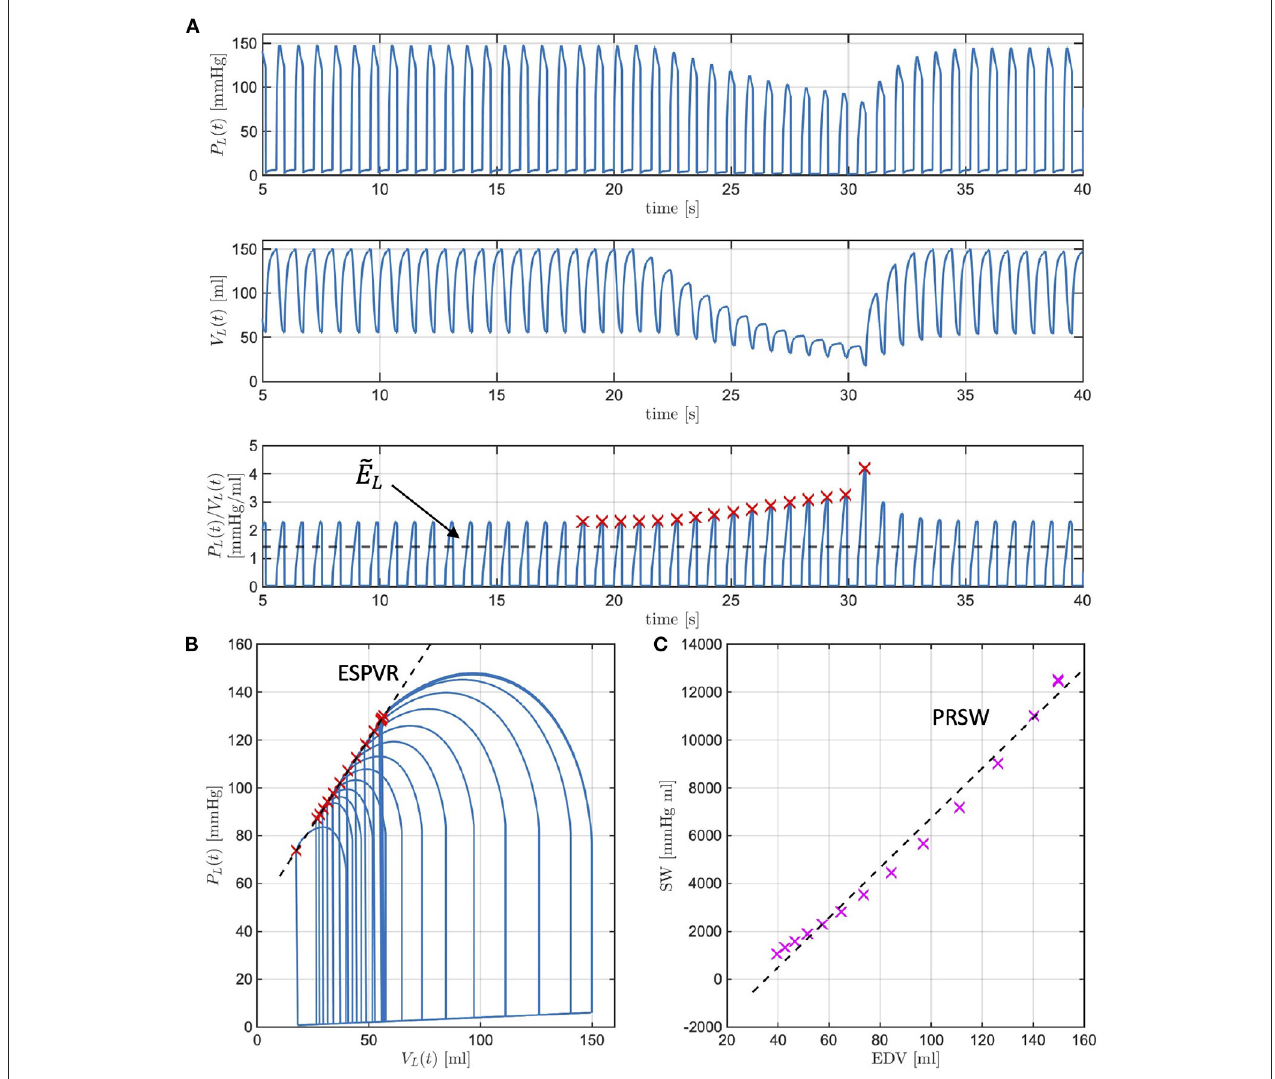
FIGURE 5 | Model-simulated pressure P L ( t ) and volume V L ( t ) in the left ventricle (LV), along with their ratio P L ( t ) / V L ( t ) representing the actual istantaneous elastance E L is independent of the loading conditions (black dashed line), whereas the actual instantaneous elastance varies as the load changes. The times at (A) . The value of which the actual instantaneous elastance attains its maximum within a cardiac cycle are noted (red crosses) and mark the end-systolic points in the P-V loops whose e interpolation gives the end-systolic pressure-volume relationship (ESPVR) (B) . The stroke work (SW) computed for each cardiac cycle is reported against the end-diastolic volume (EDV), whose interpolation determines the pre-load recruitable stroke work (PRSW) (C)